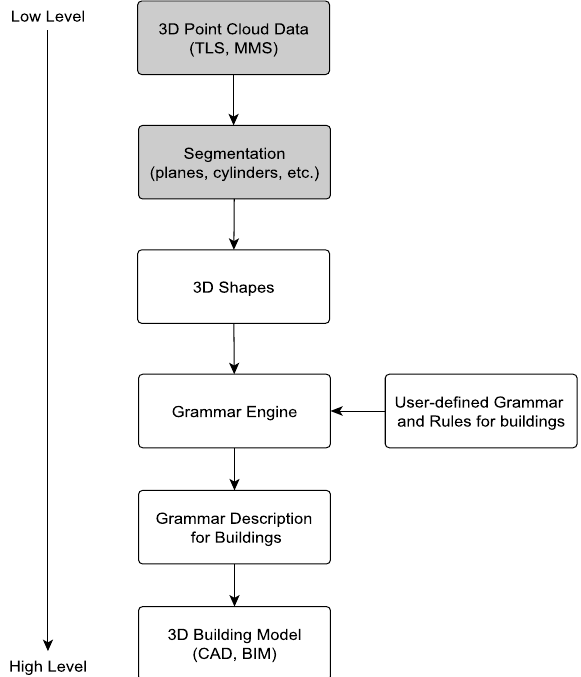
Figure 1: The main flow for proposed building model reconstruc- tion system, where the block diagram in grey indicates it is not part of our